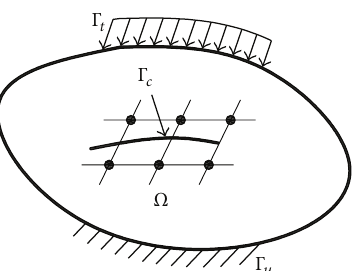
Figure1:Atwo-dimensionalbodycontainingacrackandboundary